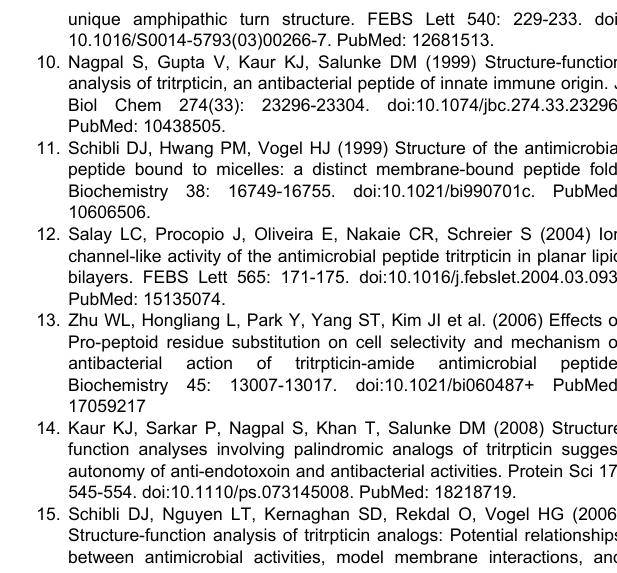
Figure S1. Generation and purification of mAb 6C6D7. A. ELISA profile of initial screening of anti-tritrpticin monoclonal antibodies. Clone 6C6 was selected for further experiments due to its ability to secrete high levels of antibody. B. Protein G